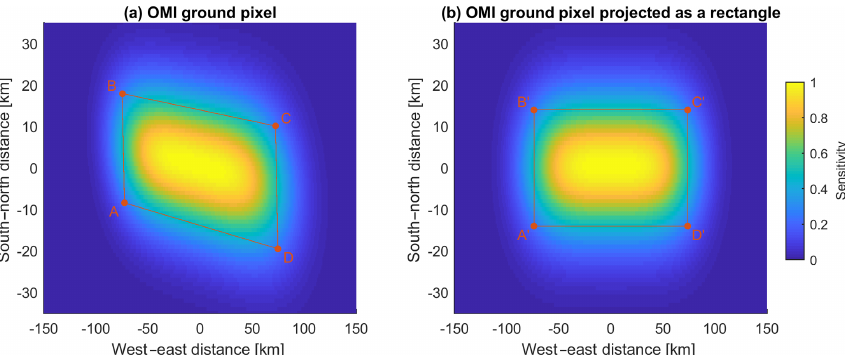
Figure 5. (a) OMI pixel corners (ABCD) for across-track position 60 out of 1–60 and spatial response function with k 1 = 4, k 2 = 2, and k 3 = 1. (b) The same OMI pixel transformed to a rectangle (A (cid:48) B (cid:48) C (cid:48) D (cid:48) ) and the corresponding transformed spatial response function. The horizontal and vertical axes are in different scales to demonstrate that the OMI pixel is not exactly a parallelogram. As a result, the geometric transformation function is projective (not exactly